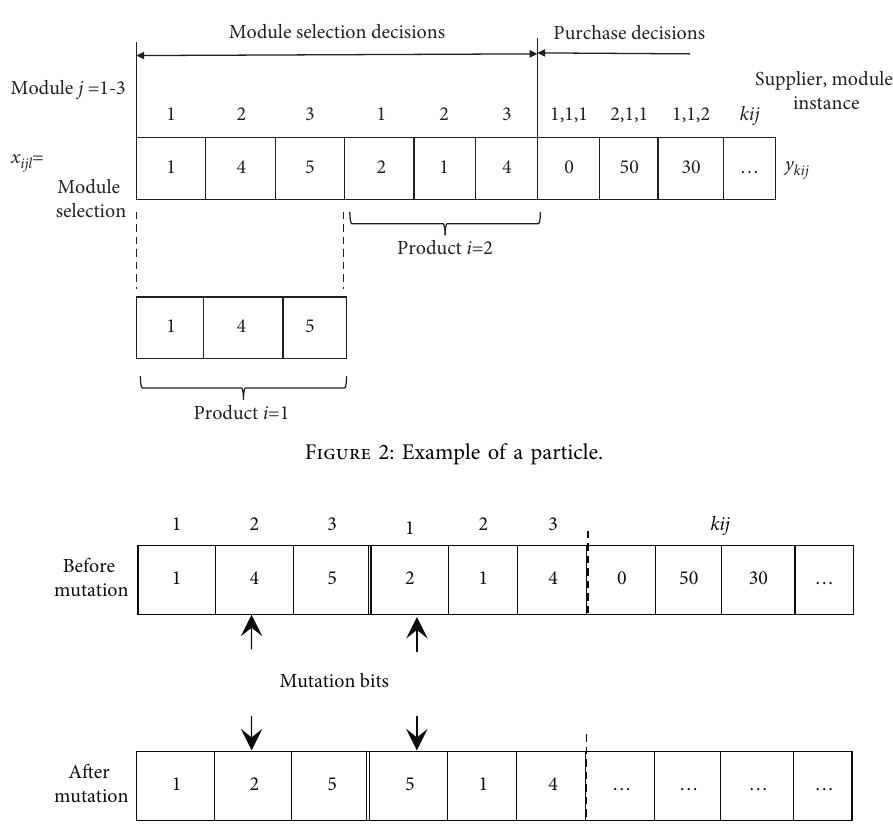
Figure 3: Mutation of a